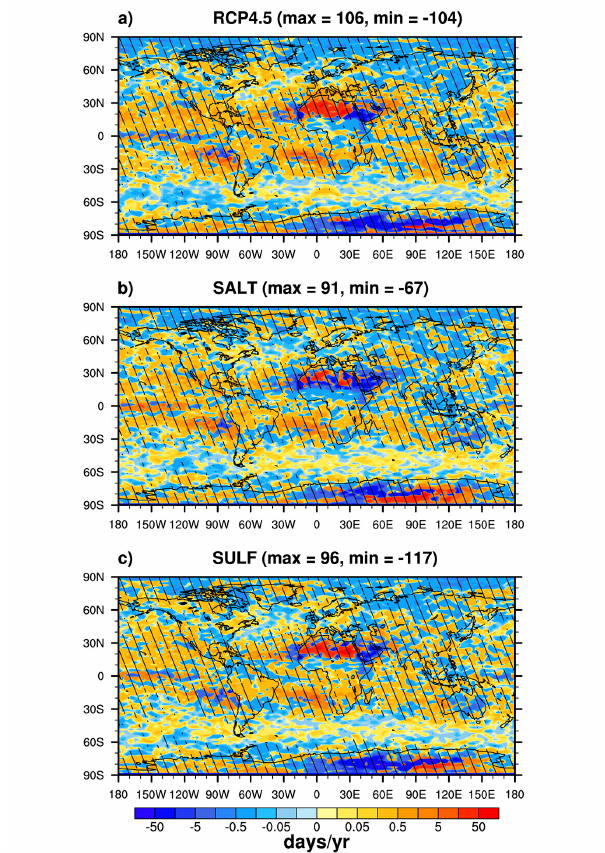
Figure 4. Multimodel mean of change in consecutive dry days RCP4.5 (top panel), SALT (middle) and SULF (bottom panel) for the 2040–2069 period minus the RCP4.5 2006–2035 control period (CTL) period. Hatches denote regions where the changes are 95% statistically